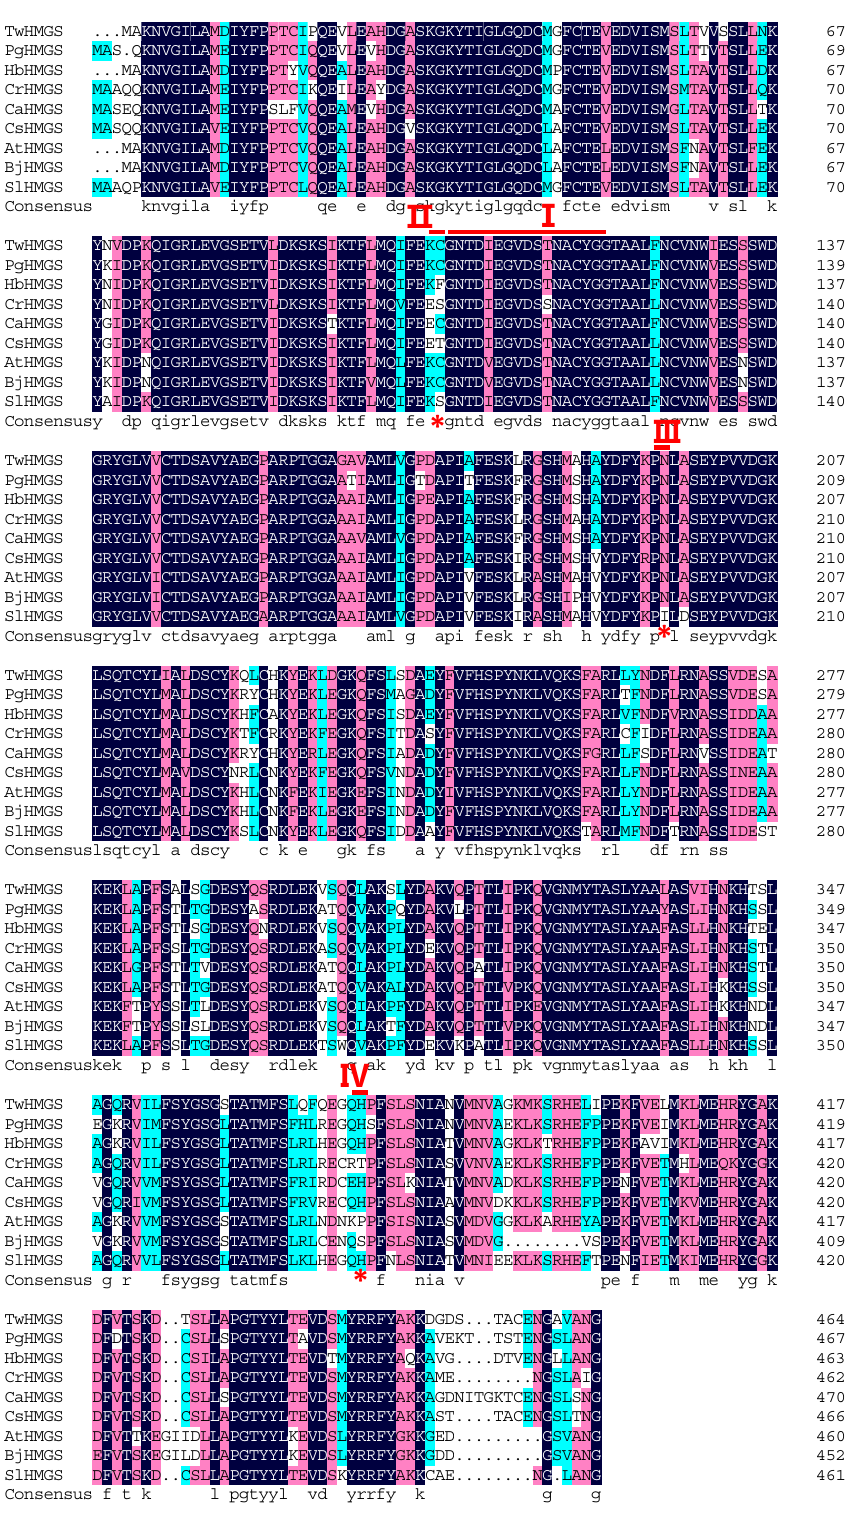
Figure 1. Alignment of Tw HMGS with other HMGS genes in